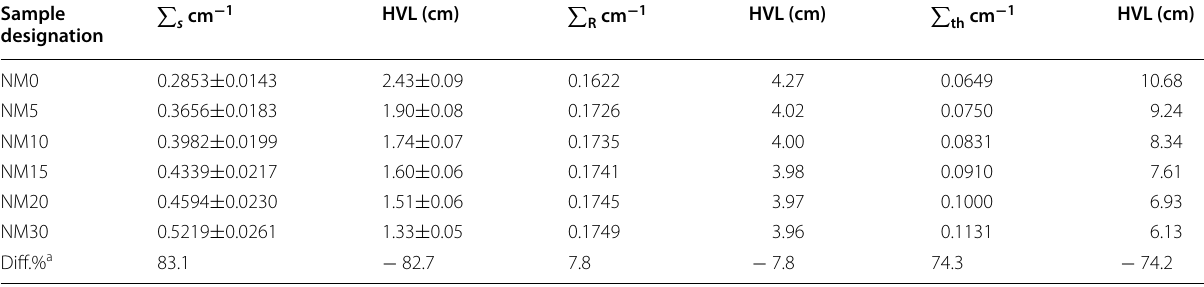
Table 5 Experimental slow neutron macroscopic cross‑sections and calculated effective removal cross‑section of fast and thermal neutrons, with their corresponding HVLs Sample